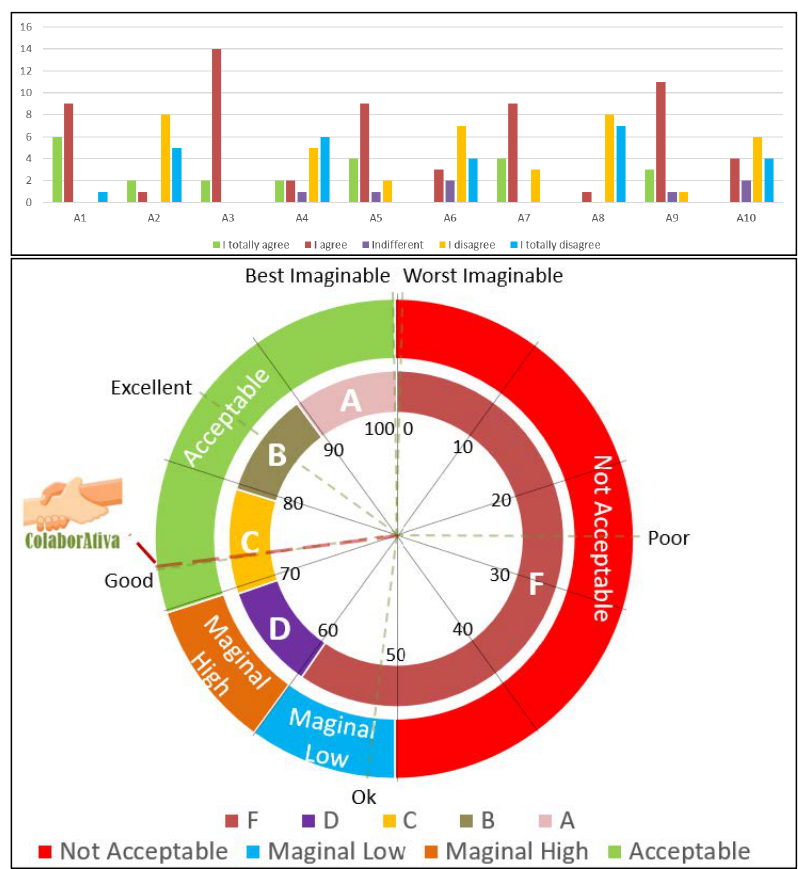
Figure 4. SUS answers and ColaborAtiva’s classification.